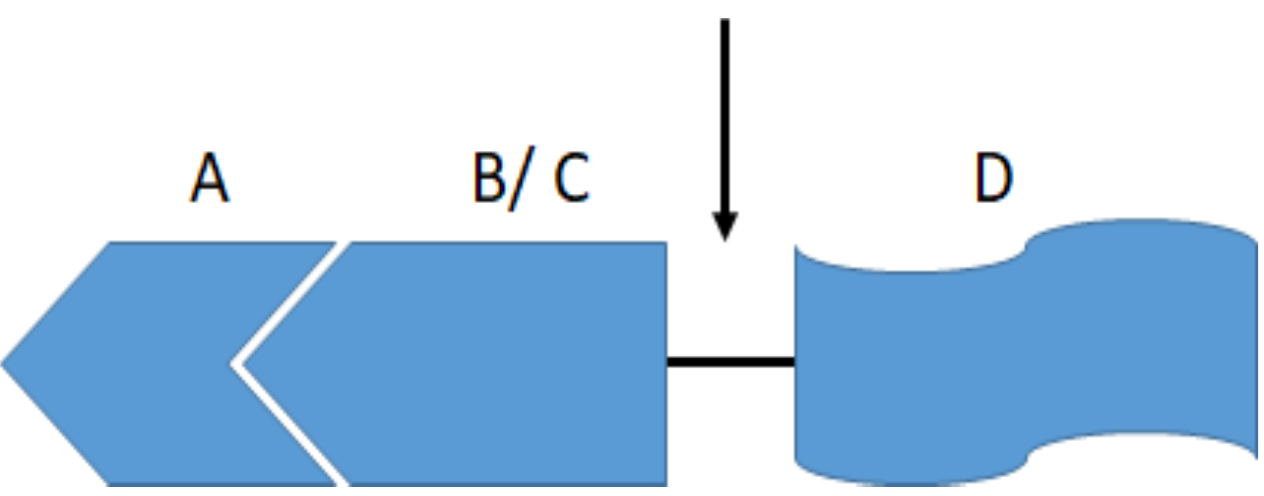
Figure 4. SUMO fusion protein. A : fusion tag 1, B : fusion tag 2, C : cleavage site, D : PAMP. For example, four interacting SUMO motif domains on the SUMO-ubiquitin E3 ligase RNF4 identify more than 300 peptides in HeLa cells using heat-shock treatment [107].